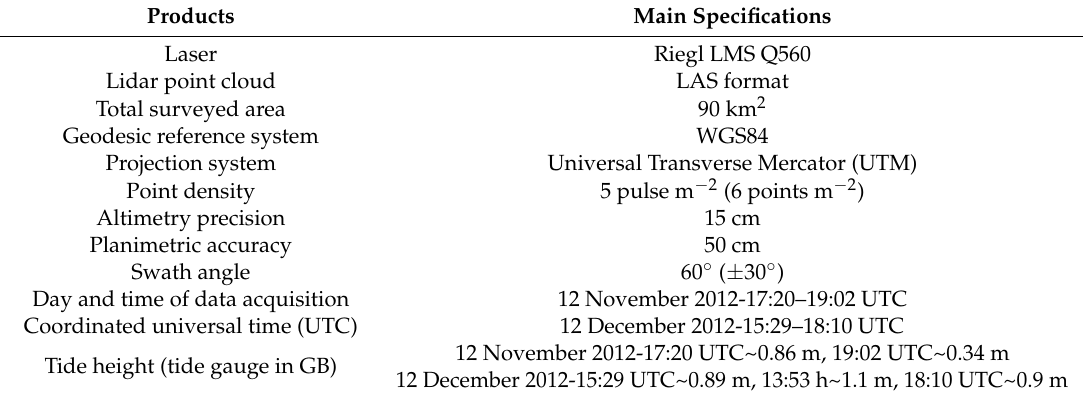
Table 2. Light detection and ranging (Lidar) data main